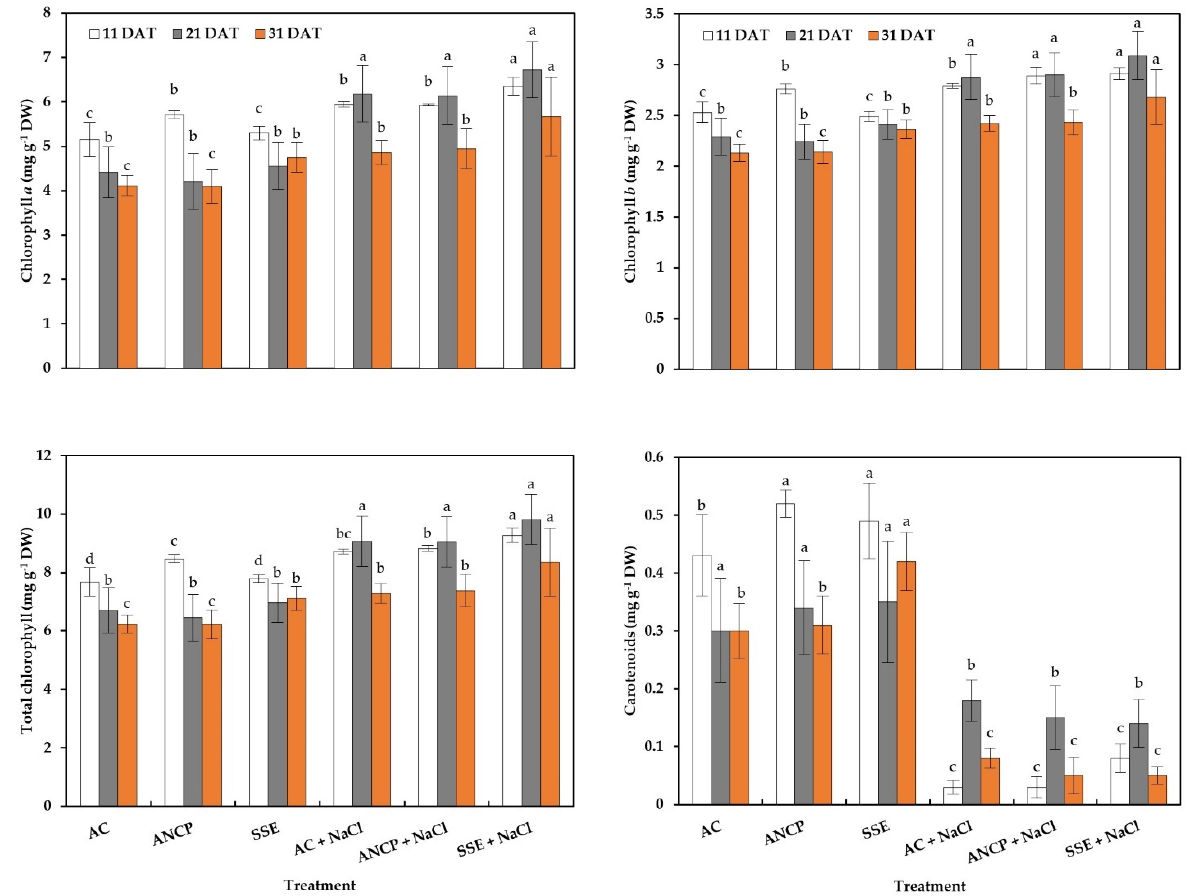
Figure 3. Photosynthetic pigments in the leaves of tomato seedlings. Different letters within each col- umn indicate significant differences between treatments (LSD, p ≤ 0.05). DAT: Days after transplant; DW: Dry weight; AC: Absolute control; ANCP: A. nodosum commercial product; SSE: Sargassum spp. seaweed extracts; NaCl: 100 mM sodium chloride; n = 5; ± bar intervals represent the SD.